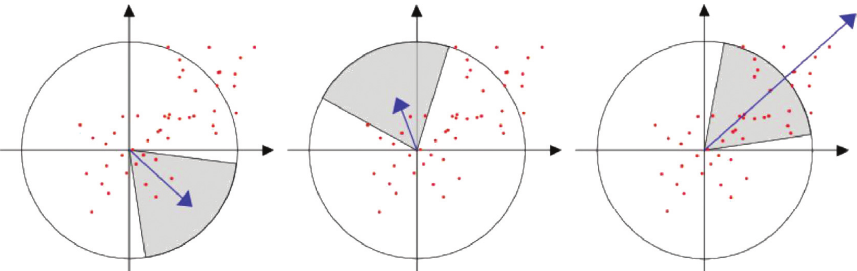
Figure 11: (a) Computing Haar wavelet responses. (b) and (c) The responses in x and y direction computed by using Haar wavelet filters with a 4s